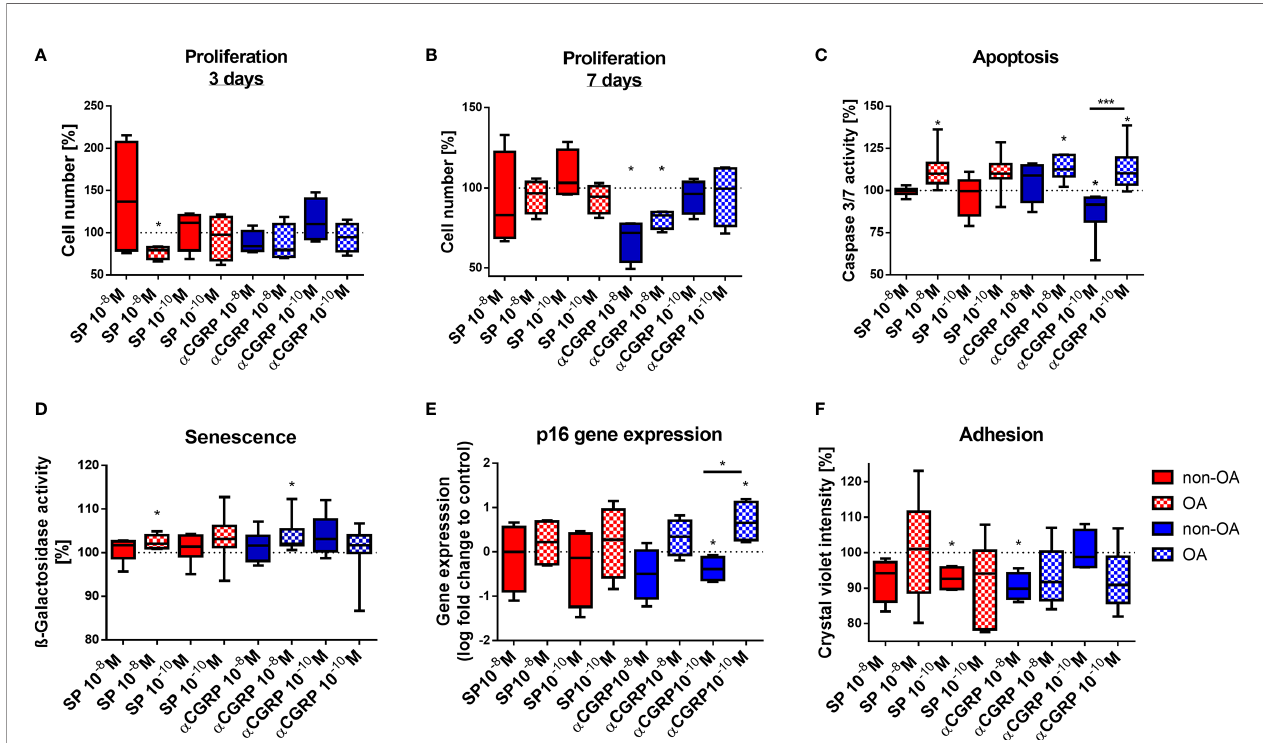
FIGURE 3 | Effects of SP and a CGRP stimulation on proliferation, apoptosis, senescence and adhesion of OA and non-OA chondrocytes. Chondrocytes were treated with either 10 -8 or 10 -10 M SP or a CGRP and then compared with the respective untreated control cells (untreated controls set to 100% = dotted line). (A, B) Proliferation was determined after 3 days and 7 days of SP/ a CGRP stimulation by cell counting. (C) Apoptosis was measured with a caspase 3/7 assay after 1 day of SP/ a CGRP stimulation. (D, E) Analysis of SA-ß-galactosidase activity and p16 gene expression revealed the senescence status of the cells after 1 day of SP/ a CGRP stimulation. (F) The adhesion capacity was analysed via crystal violet staining after 30 minutes of SP and a CGRP stimulation. Results show median (min to max); one sample t-test; *p ≤ 0,05; ***p ≤ 0,001; n =